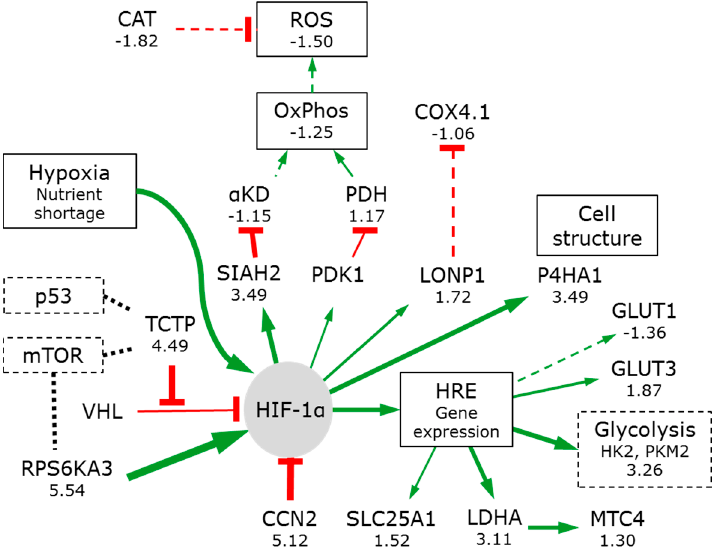
Figure 4. Effects of hypoxia on HIF-1 α . The thickness of the line indicates the ratio of protein amount in thre—dimensional (3D) cultures compared to 2D cultures. Dotted lines indicate reduced expression. Green lines ending in arrowheads indicate activators, while red lines ending in a bar indicate inhibitory activity. Dotted-boxes indicate links to other pathway figures.